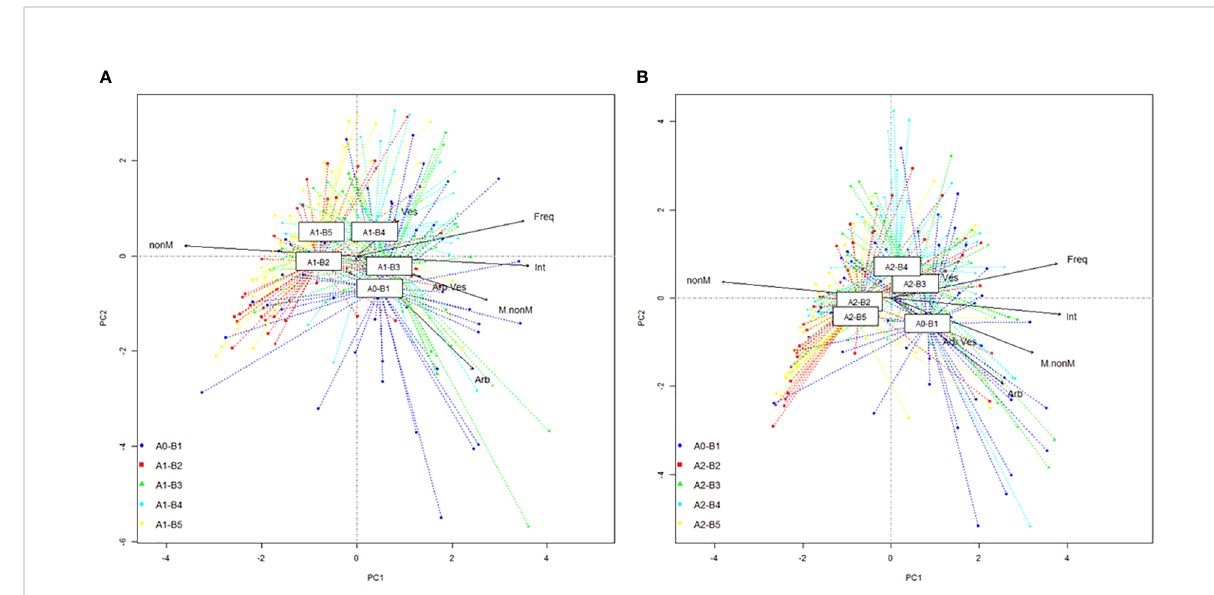
FIGURE 3 Principal component analysis (PCA) projection of phenophase-speci fi c colonization: (A) untreated plants and (B) treated plants. Legend: A0-B1, control variant (native mycorrhizal pro fi le) in phenophase 2 – 4 leaves; A1, untreated plants; A2, treated plants; B2, phenophase of 6 formed leaves; B3, phenophase of 8 – 10 formed leaves; B4, cob formation phenophase; B5, phenophase corresponding to physiological maturity; Freq, colonization frequency; Int, colonization intensity; nonM, non-mycorrhizal areas; M.nonM, mycorrhizal/non-mycorrhizal area ratio; Arb, arbuscules; Ves, vesicles; Arb.Ves, arbuscule/vesicle